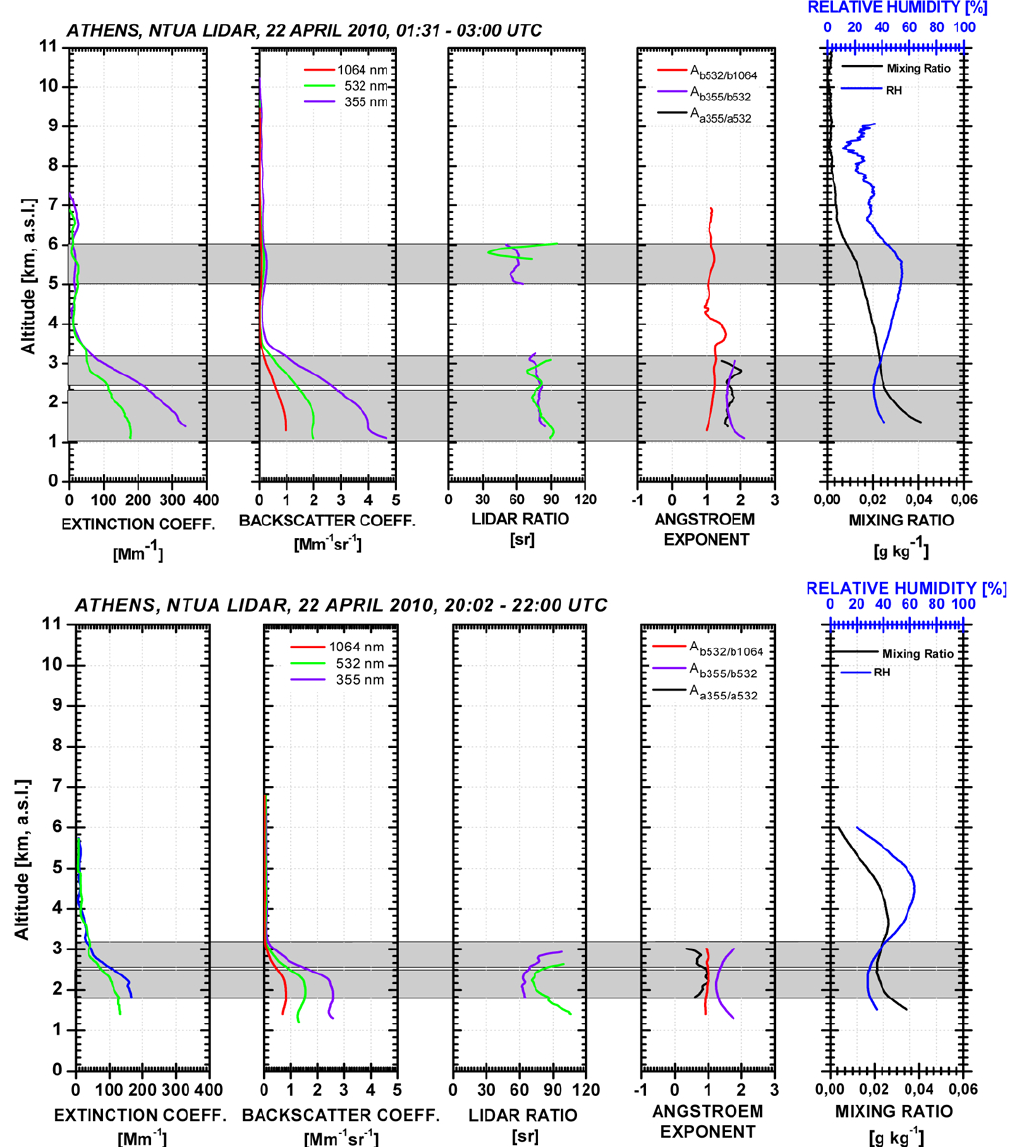
Fig. 8. Aerosol extinction coefficient at 355 and 532nm (in Mm − 1 ) ; aerosol backscatter coefficient at 355, 532 and 1064nm (in Mm − 1 sr − 1 ) ; lidar ratio ( S) at 355 and 532nm (in sr); aerosol extinction and backscatter-related Ångström exponent (355nm/532nm); water vapor mixing ratio (in gkg − 1 ) ; and relative humidity [%], as retrieved by Raman lidar measurements over Athens on 22 April 2010 between 01:30 and 03:00UTC (upper graph) and 20:00 and 22:00UTC (lower graph).